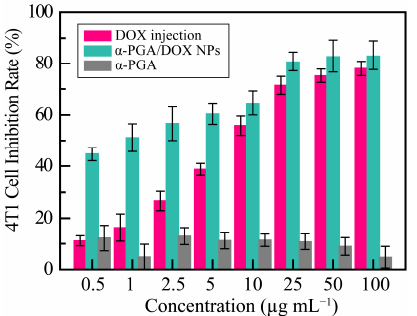
Figure 5. Inhibitory effect of α-PGA/DOX NPs after 48 h incubation ( n =